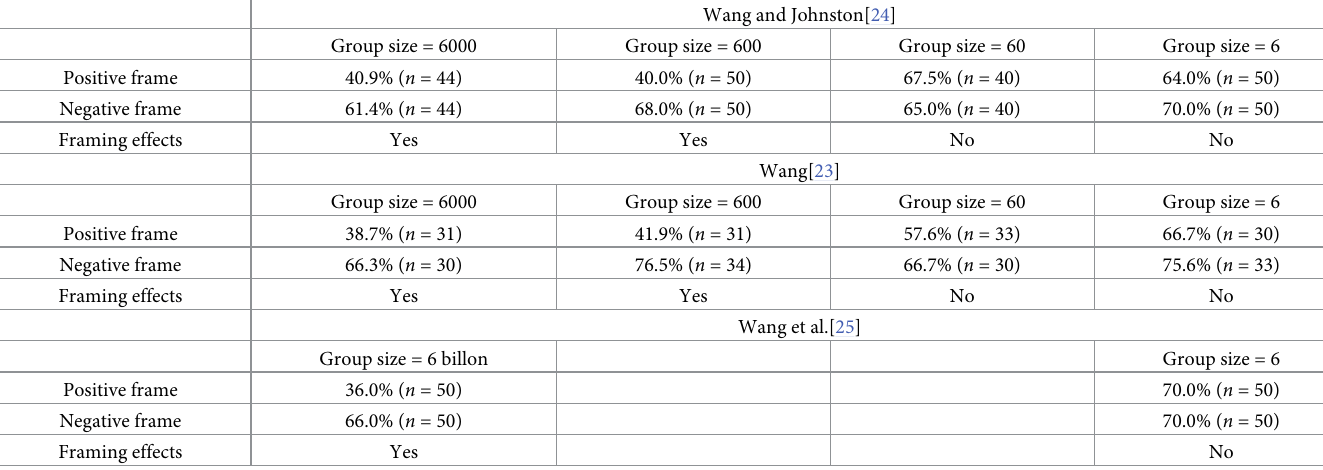
Table 1. Group size effects: Percentages of participants choosing the probabilistic